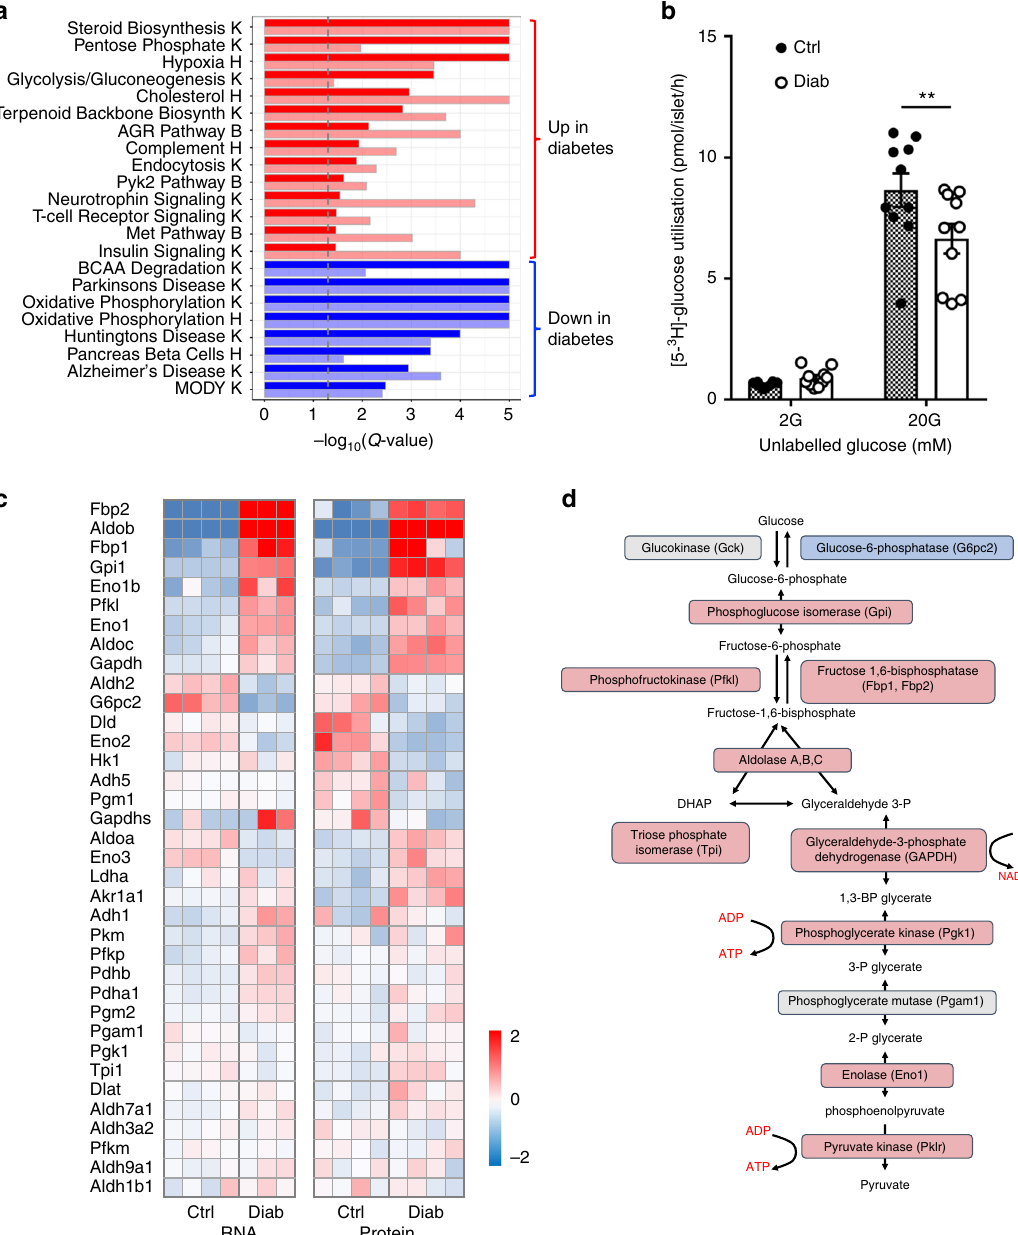
Fig. 1 Diabetes alters metabolic pathways. a Heat map of pathway enrichment, obtained by simultaneous analysis of transcriptome and proteome data sets using KEGG (K), Hallmark (H) or Biocarta (B). Red, pathways upregulated in diabetic islets. Blue, pathways downregulated in diabetic islets. Dark colours indicate proteomics, pale colours transcriptomics. The dashed vertical line indicates the level of signi fi cant change (false discovery rate-adjusted p value). PYK2, proline-rich tyrosine kinase 2. MET, tyrosine kinase MET. BCAA, branched chain amino acids. MODY, maturity onset diabetes of the young. b Glucose utilisation measured as the production of 3 H 2 O from [ 3 H]-glucose in control islets (hatched, n = 10 replicates, islets from 4 mice) and 2-week diabetic β V59M islets (white, n = 10, 6 mice) at 2 mM glucose (2 G) and 20 mM glucose (20 G). ** p < 0.01 (two-way analysis of variance). Data are mean ± s.e.m. c Heat maps of relative mRNA and protein expression of the indicated genes in islets isolated from control (Ctrl) and 2-week diabetic (Diab) β V59M mice. Each box indicates a separate animal. Colour indicates log 2 fold-change for diabetic vs control islets. d Glycolytic pathway. Elevated protein expression levels shown in red, decreased protein levels in blue. Grey, no change or not